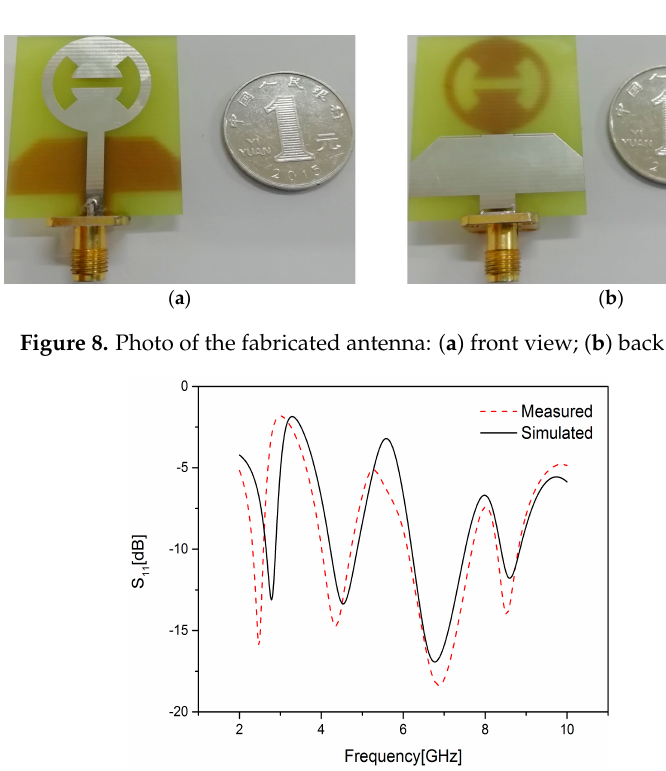
Figure 10. Schematic of the equivalent RLC resonant circuit model of the proposed antenna.